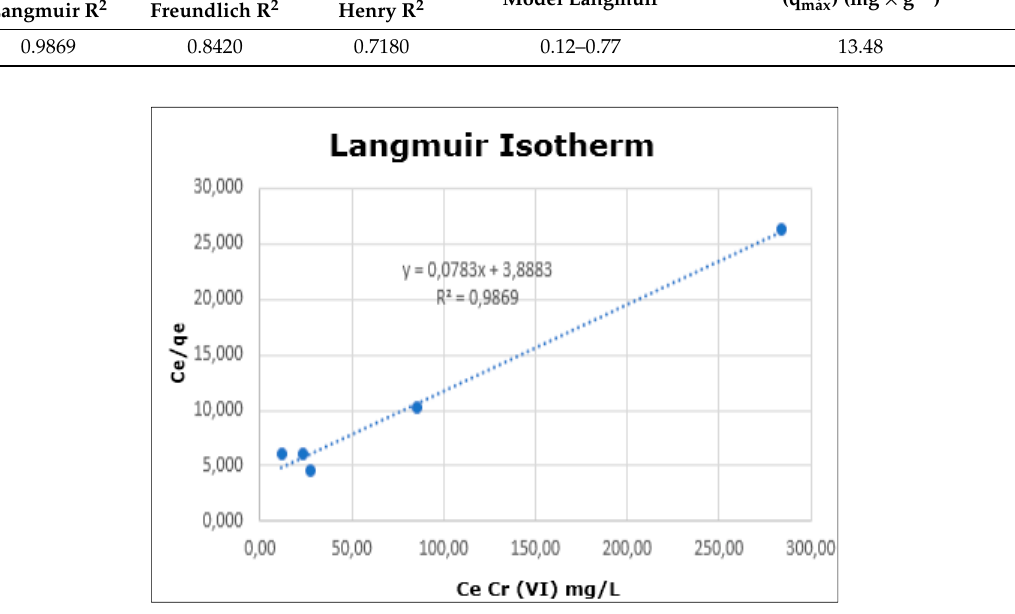
Figure 7. Linearized Langmuir Model for Cr (VI) with CP.